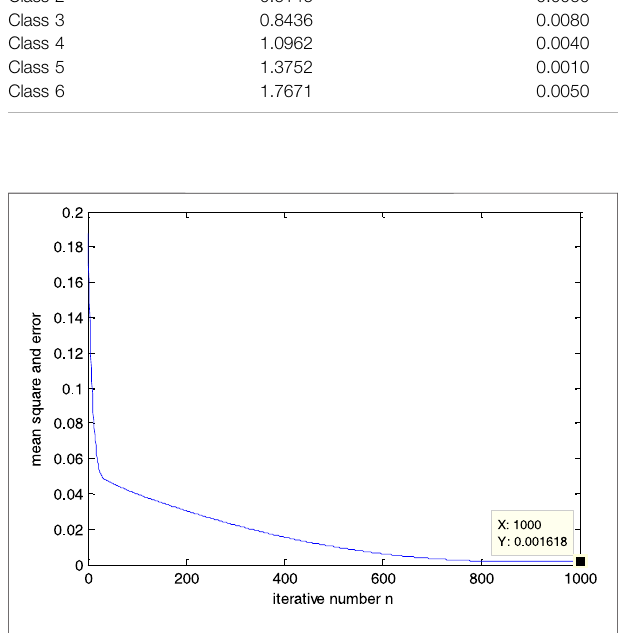
FIGURE 6 | | The modi fi ed BP neural network training error during